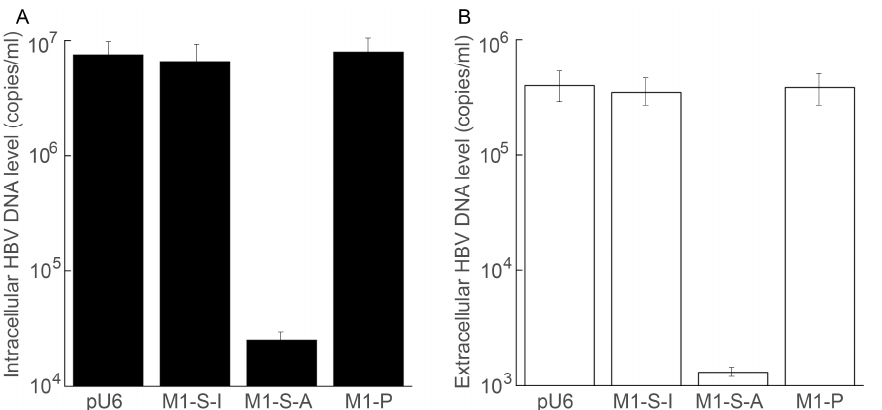
Figure 5. Inhibition of HBV intracellular DNA replication and virus production in HepG2.2.15 cells expressing RNase P ribozyme. HBV capsid-associated DNAs were isolated from ribozyme-expressing cells ( A ) or their culture media ( B ), and their levels were determined by qPCR. The values are the average of triplicate experiments. The error bars showed the standard deviation.